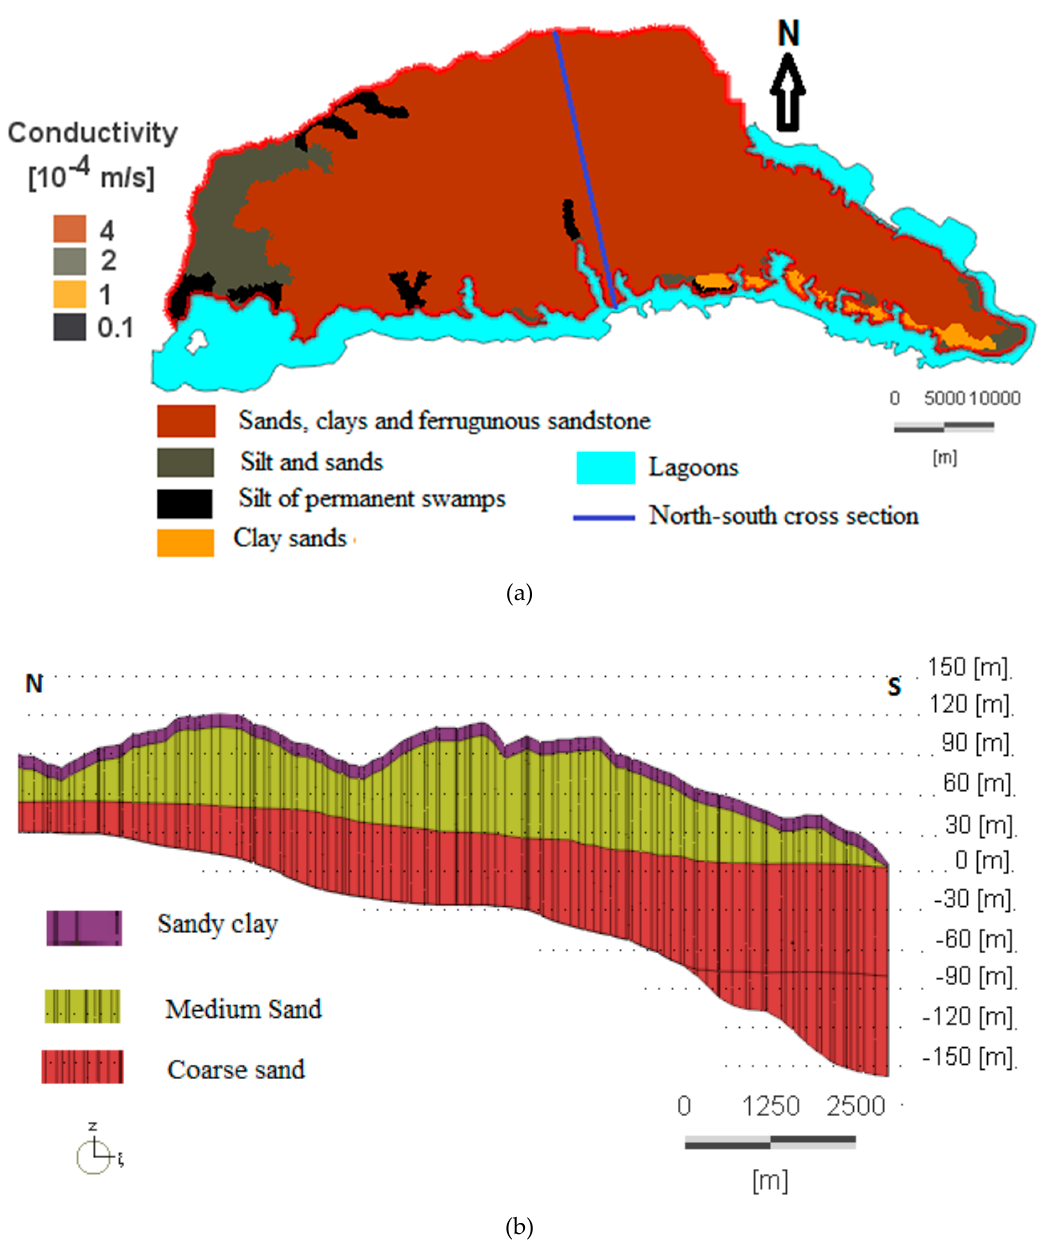
Figure 5. Model characteristics: ( a ) map of the superficial geological formations of the model and the corresponding hydraulic conductivities, and ( b ) north–south profile of the model layers.